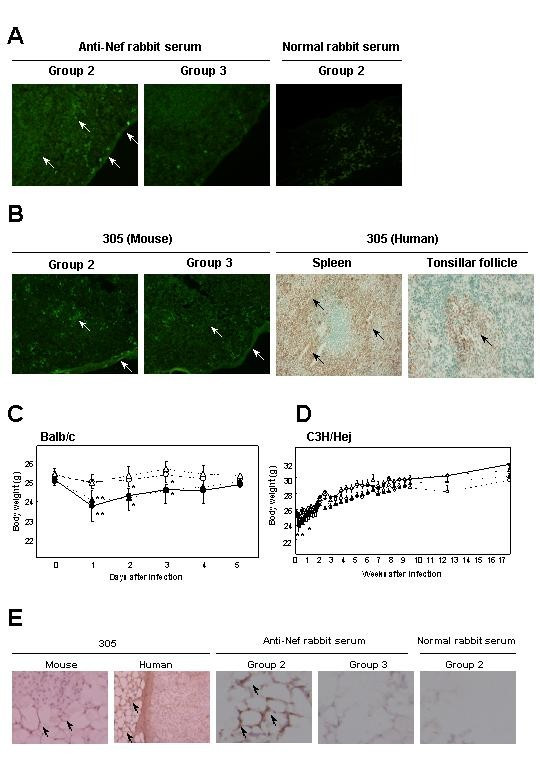
In vivo effects of miR-N367. (A) Distribution of Nef positive staining cells in the subcapsular area of groups 2 or 3 mouse spleens at 2 days after infection with PFV/nef. Anti-Nef rabbit serum or normal rabbit serum was used as a primary antibody. (B) Immunofluorescence for 305 mAb positive staining cells in the subcapsular area of groups 2 or 3 mouse spleens at 2 days after infection with PFV/nef and immunoperoxidase staining by 305 mAb in cells of interfollicular area of HIV-1 uninfected human spleen and tonsillar follicle. (C) Short term body weights of PFV/nef-infected Balb/c mice. The body weights of the PFV/nef-infected mice (group 1, n = 6, solid circle), the PFV/nef-infected followed by the STYLE-luc-infected mice (group 2, n = 6, solid triangle), the PFV/nef-infected followed by the STYLE-367-infected mice (group 3, n = 8, open triangle) and the STYLE-367-infected mice (group 4, n = 6, open circles) were measured from days 0 to 5. (D) Long term body weights of PFV/nef-infected C3H/Hej mice. Treatment of each group and numbers of mice were same as (C). Bars, SD. *; p < 0.05, **; p < 0.01 (relative to group 3). (E) Immunoperoxidase staining by 305 mAb and anti-Nef rabbit serum in cells of mouse or human adipose tissue. Arrows show positively stained areas. Magnification, X 20 (A and B); X 20 and X 200 (E).